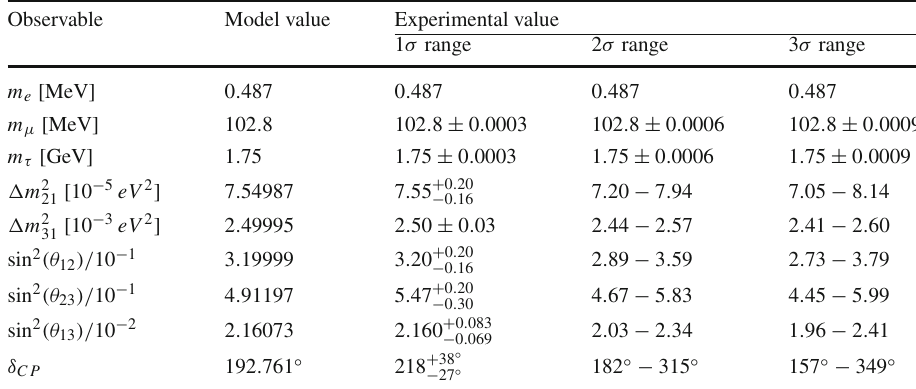
Table 6 The model values shown in the table are the best fit results for the neutrino mass squared differences, mixing angles and the CP-violating phase for the case of normal hierarchy. The 1–3 σ experimental ranges [212] are also shown for